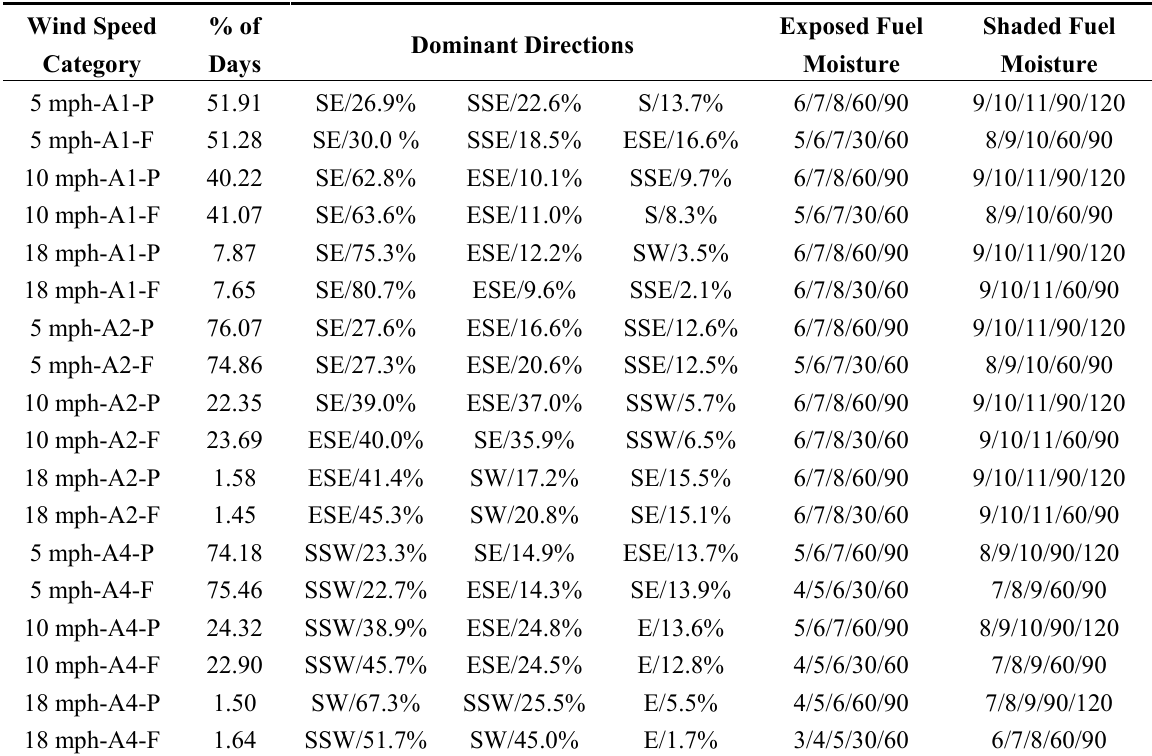
Table 1. Weather outputs from RCM RACMO2 used to create the weather scenarios input files for Randig simulations. A1, A2 and A4 are the three RCM prediction points; P: Present; F: Future; Fuel moisture values represent 1 h, 10 h, 100 h, live herbaceous and live woody fuel moisture content classes,